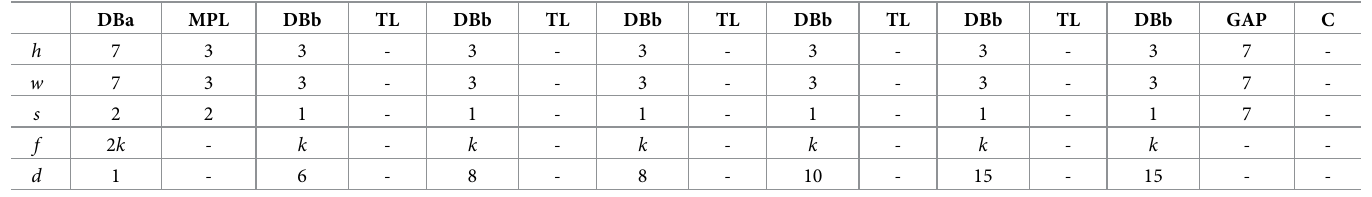
Table 3. Structure of the DenseNet-1024 classifying 1024 × 1024 px confocal microscopy images of cardiomyocytes into development stages. DBa